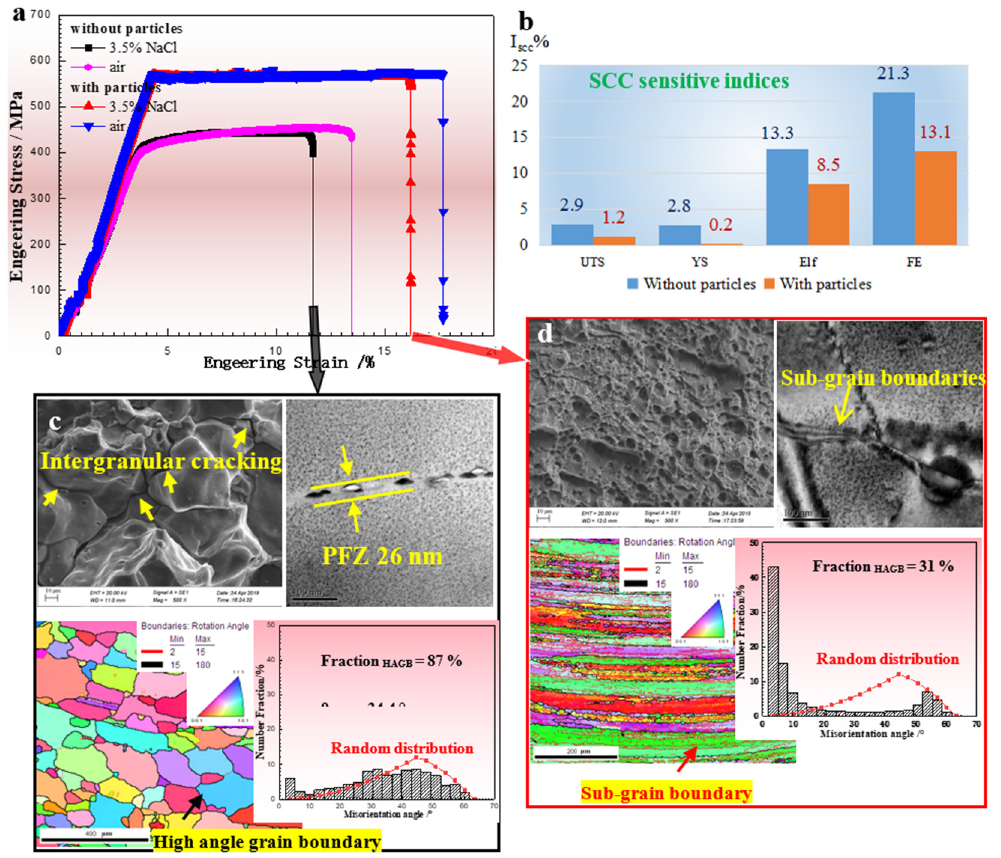
Figure 2. SSRT results of the aged alloy with and without particles and the corresponding microstructures. ( a ) Tensile curves; ( b ) SCC sensitive factors; ( c , d ) SEM fracture surface, EBSD and bright-field TEM images of the alloys failed in corrosive environment.